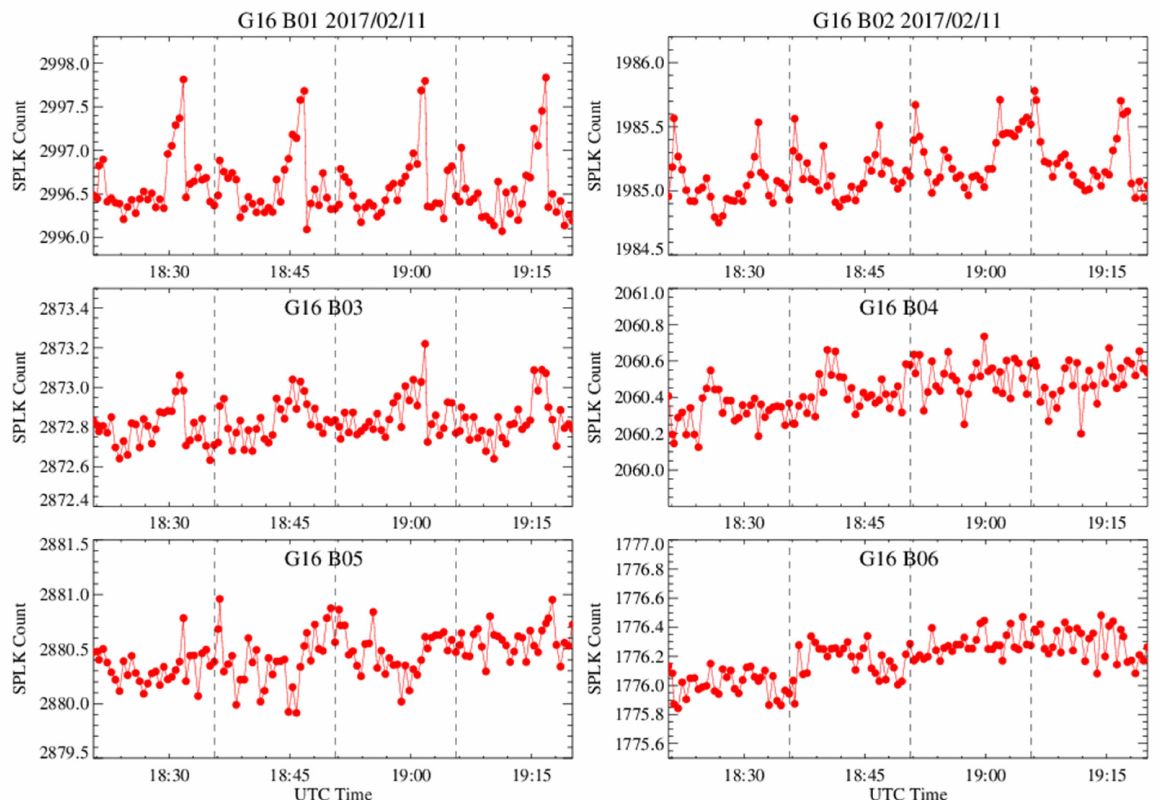
Figure 10. Time series of the mean spacelook (SPLK) values for the G16 VNIR band during the lunar chasing event on 11 February 2017. The vertical dash line is the starting time for each 15 min